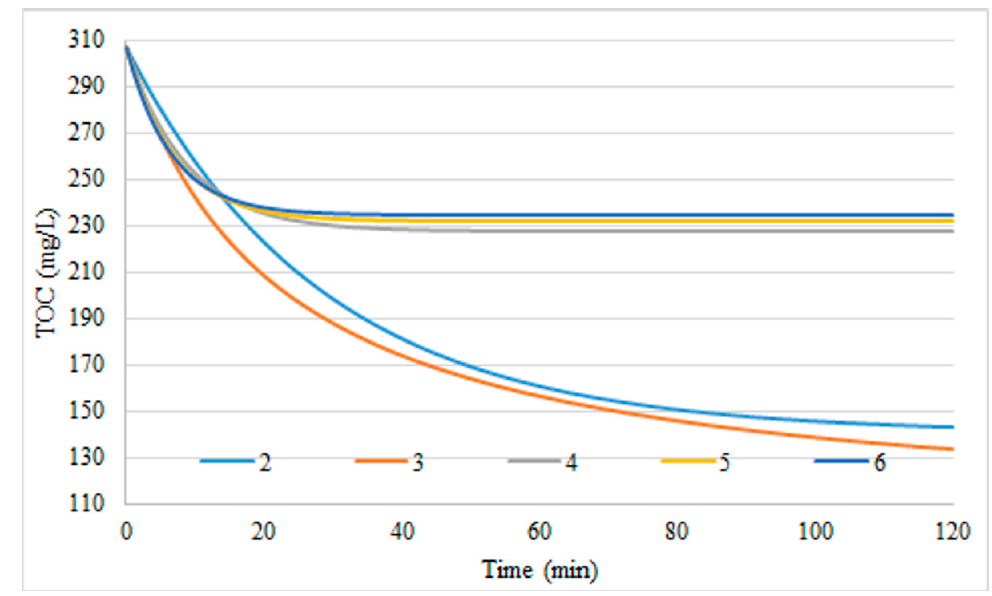
Figure 6. CW treatment results at different pH, 500/500/1000 Fe 3 O 4 /Fe 2 O 3 /Fe 0 doses (mg/L) H 2 O 2 /COD mass ratio 1:1, UV irradiation. H 2 O 2 /COD mass ratio 1:1, UV